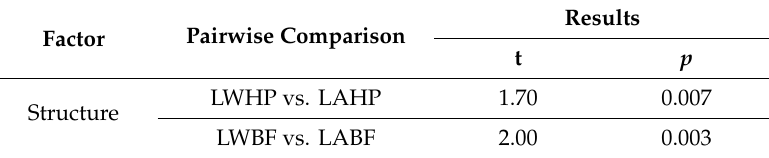
Table 2. Pairwise comparisons after the main test (PerMANOVA) on the frequency of the number of approaches to the outside areas (UL and DL) and entrances (IL) in the L-structures by L. bocagei (n = 45) regarding the structure factor.